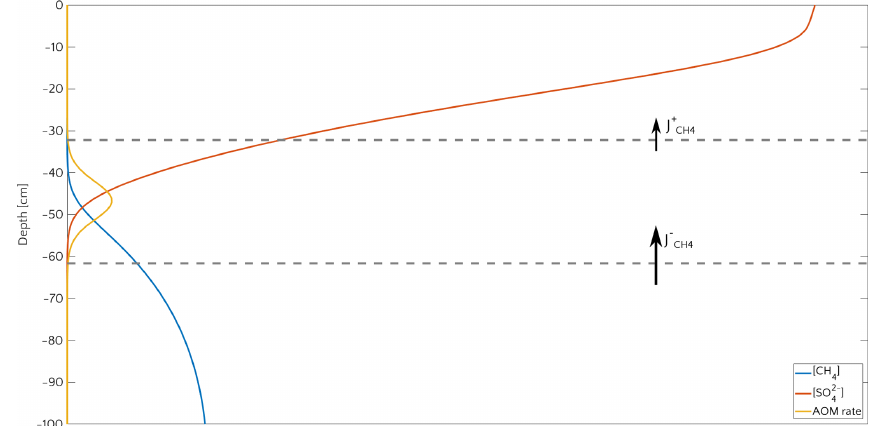
] , [ CH ] and AOM 4 4 and J + are CH 4 CH 4